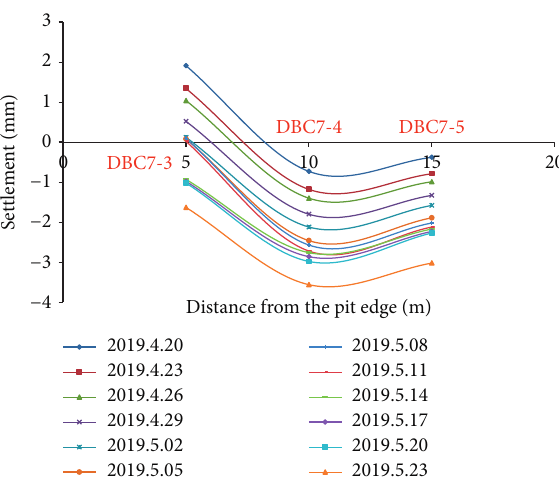
Figure 9: Surface settlement variation of equidistant distance. Table 7: The ground surface settlement about DBC7-3 to